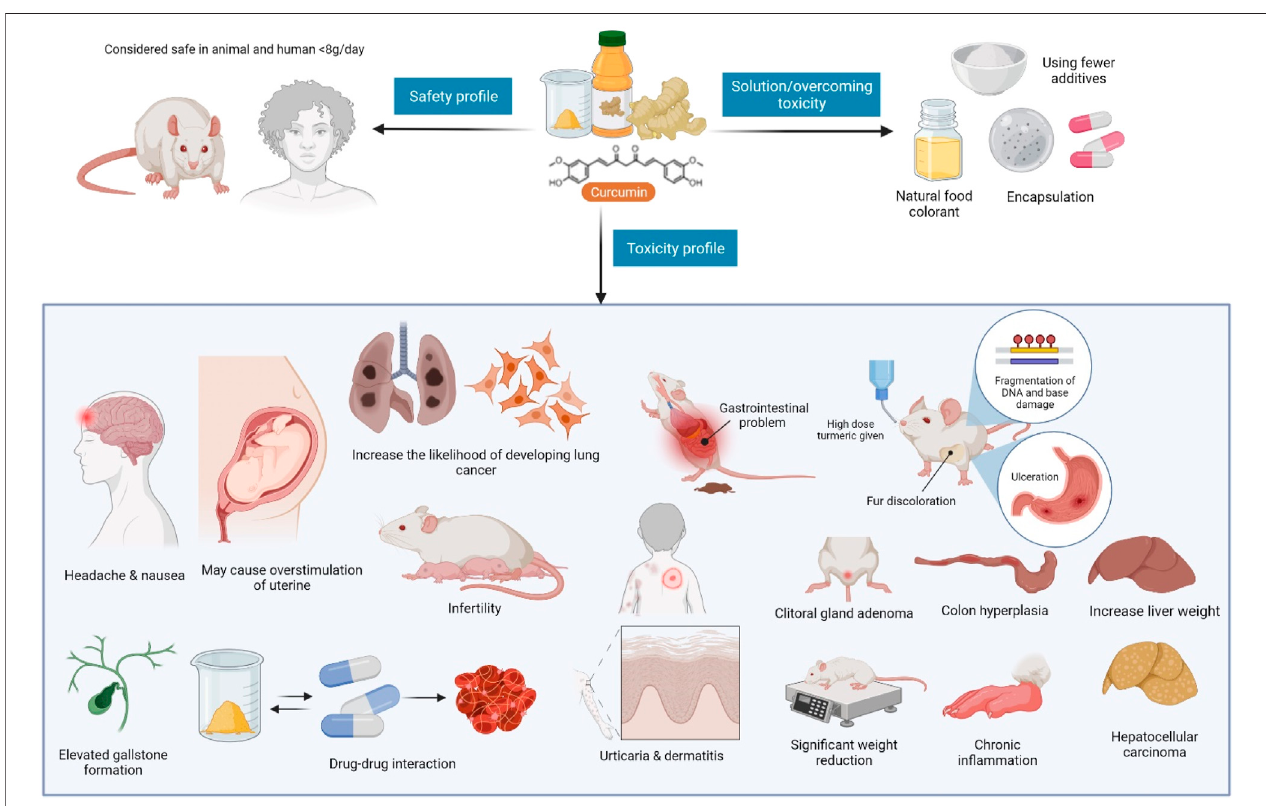
FIGURE 9 | Curcumin safety, toxicity pro fi les, and solution to overcome it. Curcumin safety, toxicity pro fi les, and a way to circumvent it. Despite its recognized safety, certain investigations have highlighted unprecedented side effects of curcumin, including gastrointestinal problems, chronic in fl ammations, and others. To